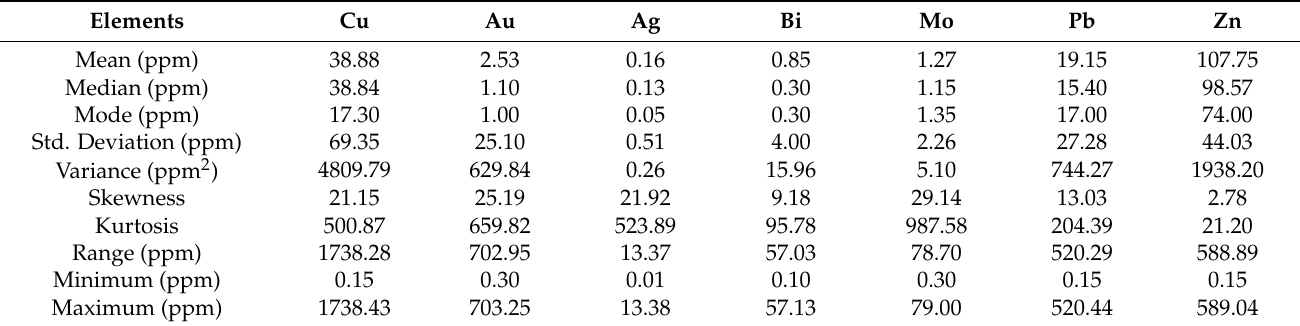
Table 2. Descriptive statistical parameters of Cu, Au, Ag, Bi, Mo, Pb and Zn based on 1428 geochemical stream sediment samples (Raw Data).